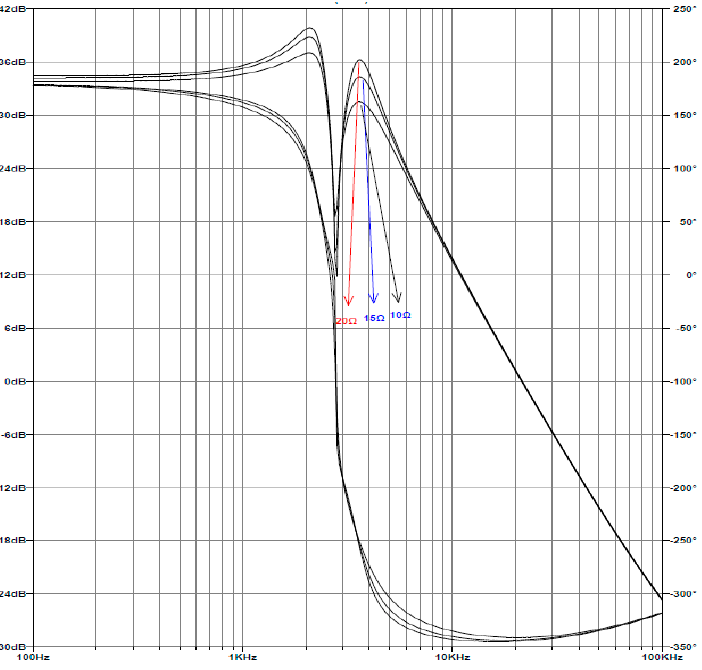
Figure 17. G vd for Cuk for variable R. The frequency response of G vd obtained from the circuit averaging and small signal